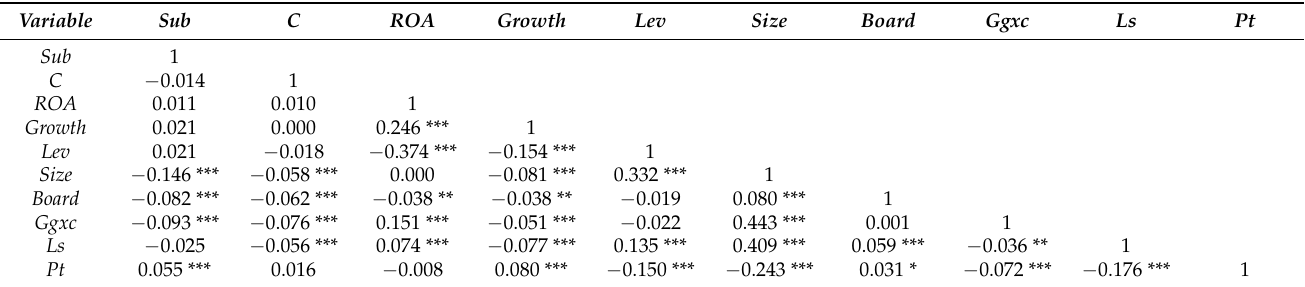
Table 2. Pearson correlation